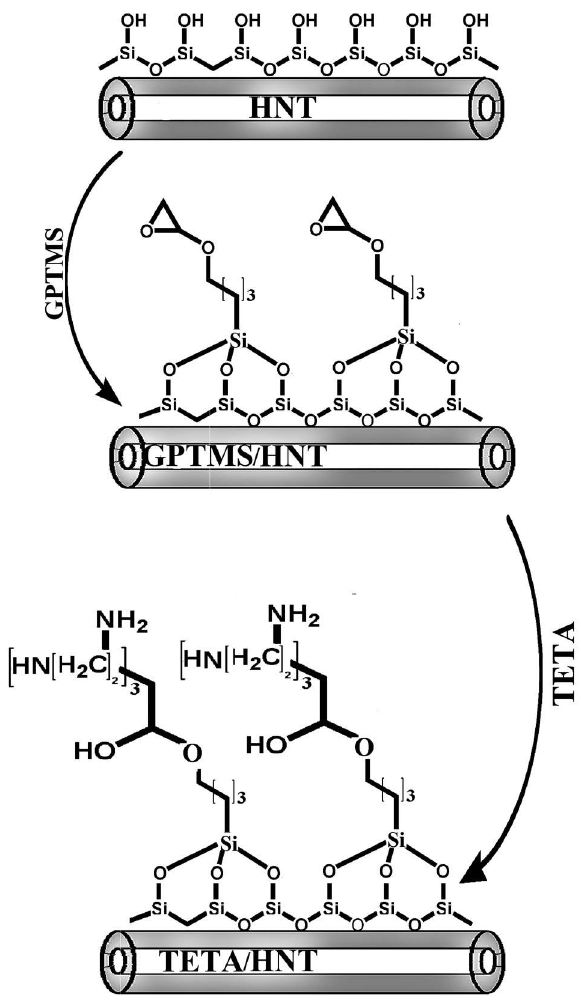
Fig 2. Schematic Illustration of the role of GPTMS and TETA in the formation of the